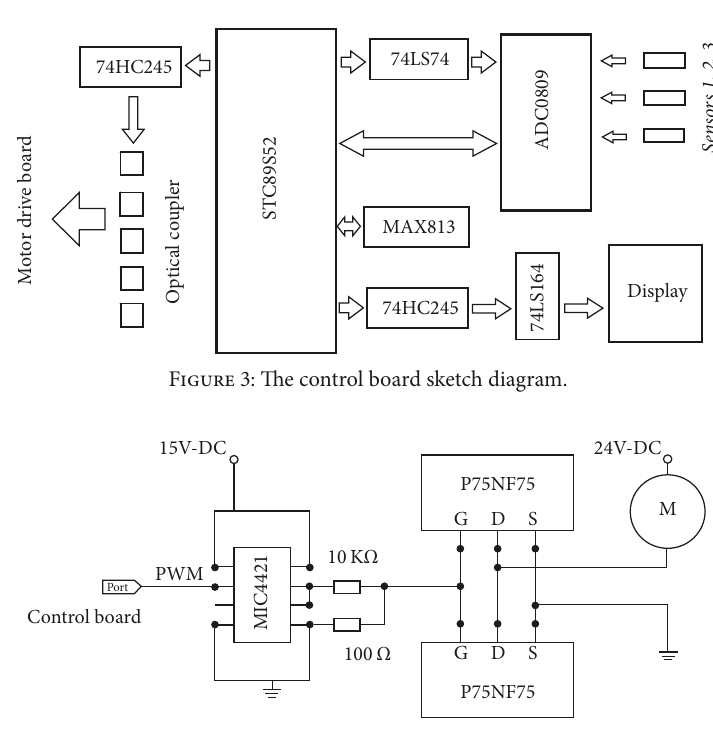
Figure 4: The sketch diagram of one channel of the motor drive board.